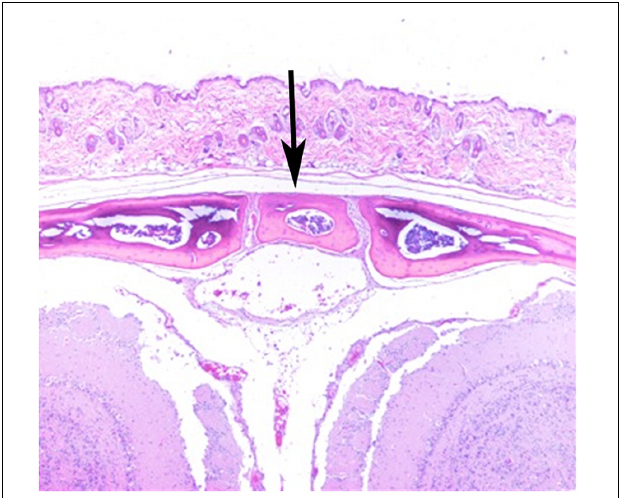
FIGURE 2 | H&E of a coronal section from a C57BL/6J mouse showing IF (arrow).